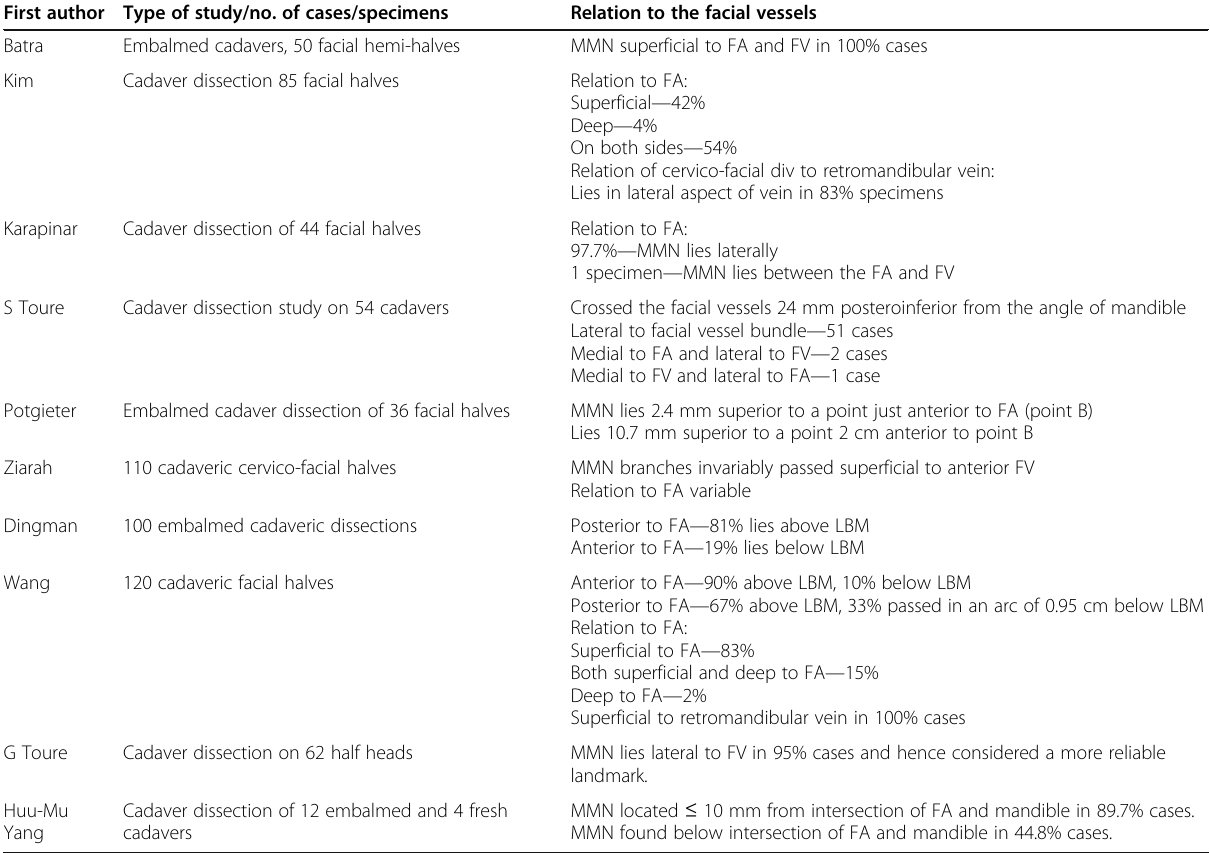
Table 3 Relation of MMN with facial